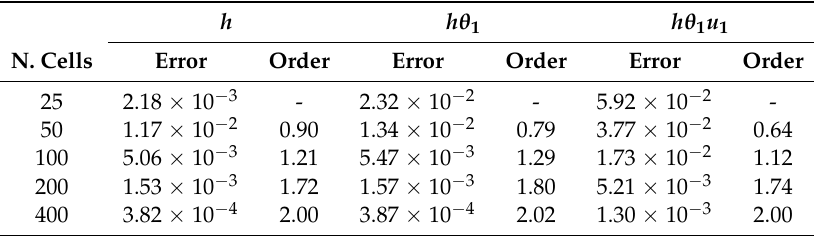
Table 2. Order of accuracy for the second order